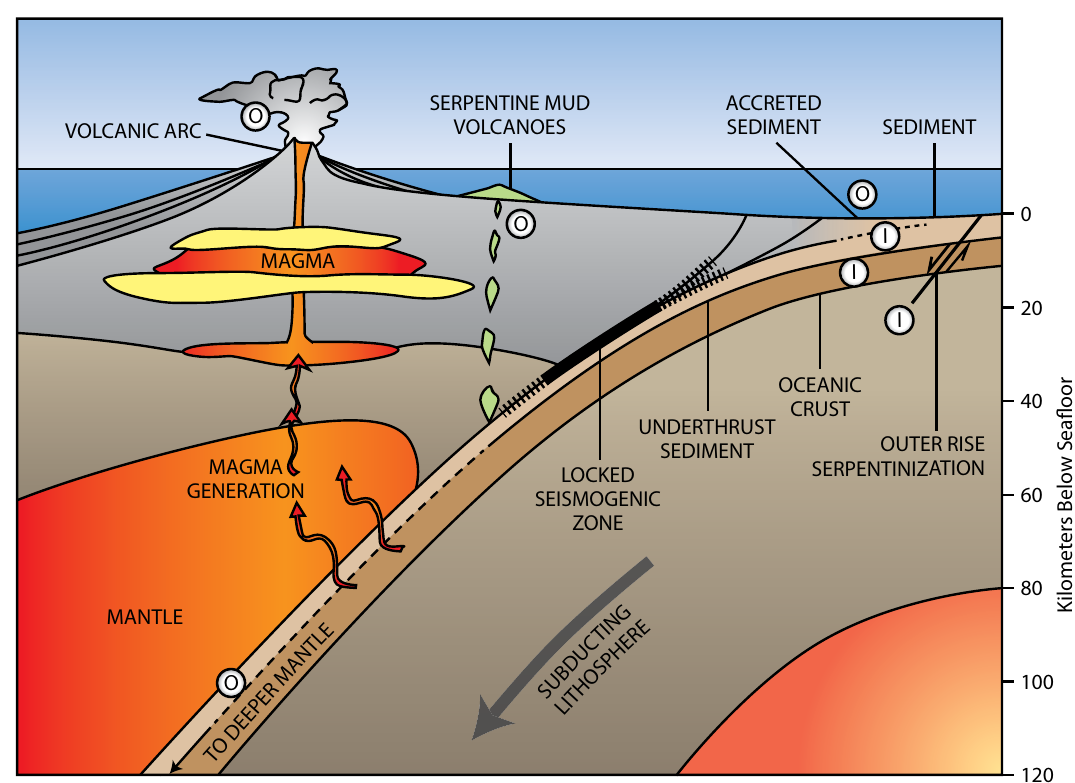
figure 4.8. cartoon of a subduction zone showing major inputs (i), outputs (o), fluid and melt pathways, and arc crust structure. oceanic crust is covered by a thick accumulation of marine sediments and has been extensively altered by millions of years of hydrothermal circulation, including microbial and abiotic reactions. outer rise faults may hydrate subducting mantle lithosphere, and the resulting serpentine is a major potential water input to the subduction zone. fluids (h 2 o and co 2 ) from sediments and altered volcanic rocks escape into the accretionary prism, overlying plate, and mantle wedge during subduction, leading to formation of cold seeps and mud diapirs on the forearc, great earthquakes in the locked seismogenic zone, and mantle melting below the volcanic arc. magmas generated in the water-fluxed mantle wedge may stall and freeze, creating future continental crust, or erupt explosively and provide a drillable record of the net recycling and crustal growth